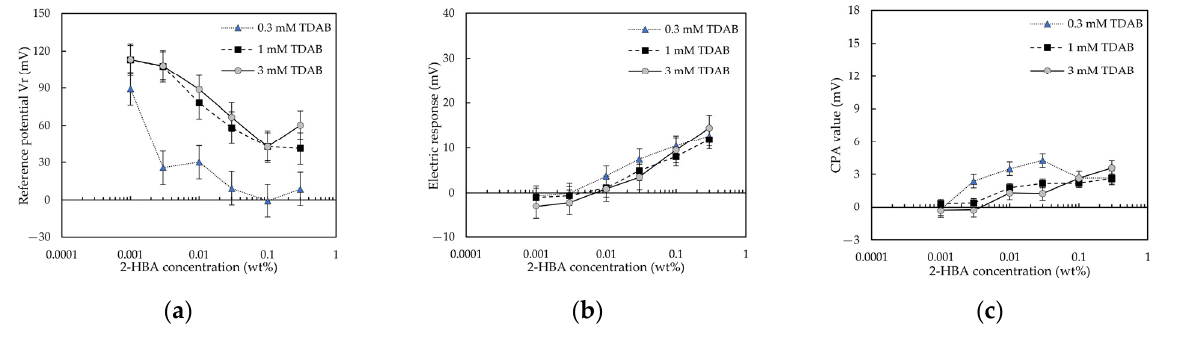
Figure 8. The 2–HBA-concentration-effect curves for 100 mM caffeine obtained using the taste sensor with the lipid/polymer membrane (0.3, 1, and 3 mM TDAB): ( a ) change in reference potential; ( b ) change in electric response; and ( c ) change in CPA value.